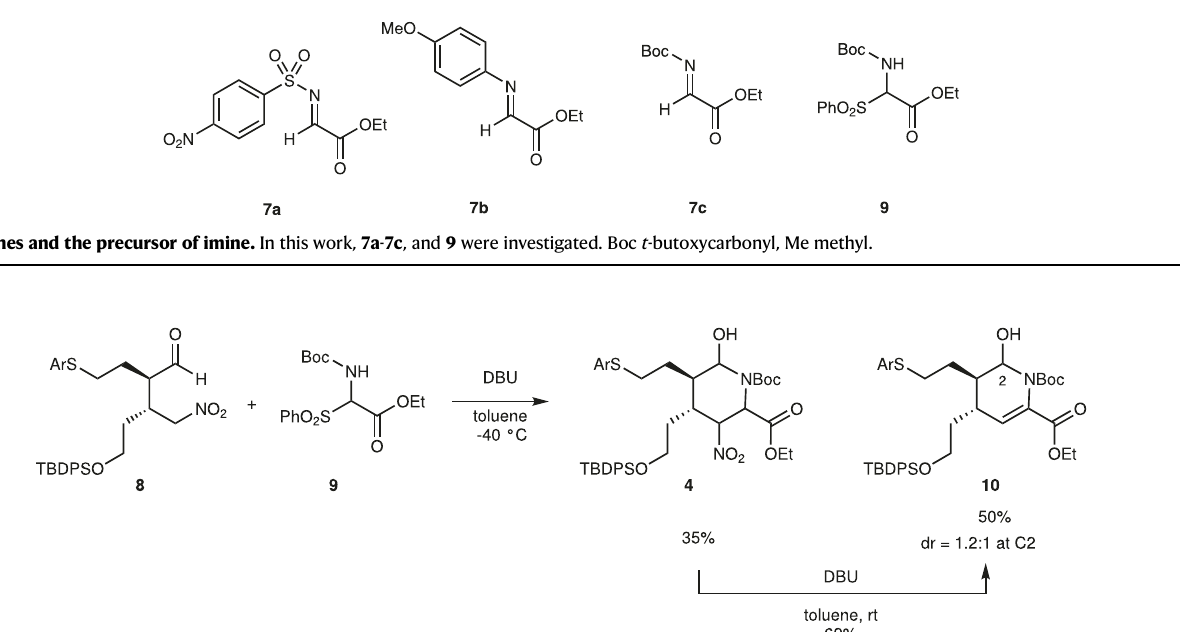
Ar = 4- t BuC 6 H 4 - pot 1: Five reactions in one-pot sequence, 66% (10.8 g)